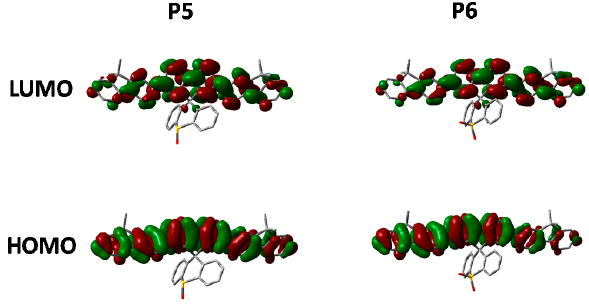
Figure 9. HOMO and LUMO orbitals of P5 and P6 (DFT B3LYP/6-31G* isovalue 0.02).